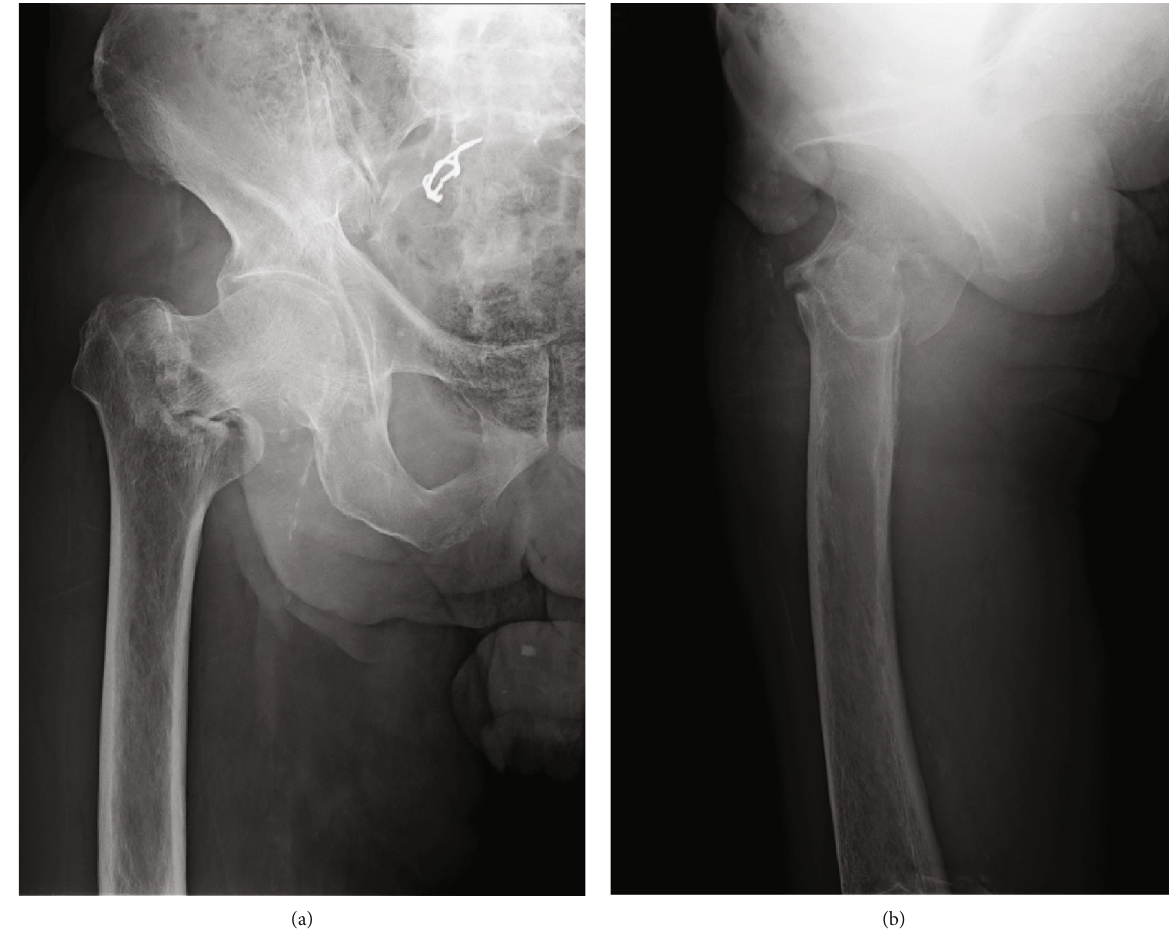
Figure 1: Anteroposterior (a) and lateral (b) radiographs taken on initial presentation showing a trochanteric fracture with a greater trochanteric fragment in the right femur, which are classi fi ed as AO type 31A2.2 and Jensen type